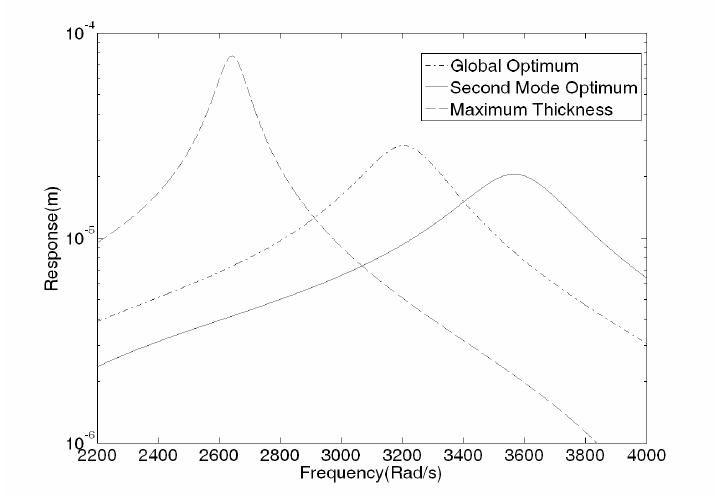
Fig. 13. Comparsion between the local optimum configuration in the second mode, the overall optimum configuration and the configuration with maximum thickness of damping layer and constraining layer. The visco and constraining layer thicknesses for the local optimum are 0.0001 m and 0.002 m, and for maximum thickness configuration are 0.002 m and 0.002 m,